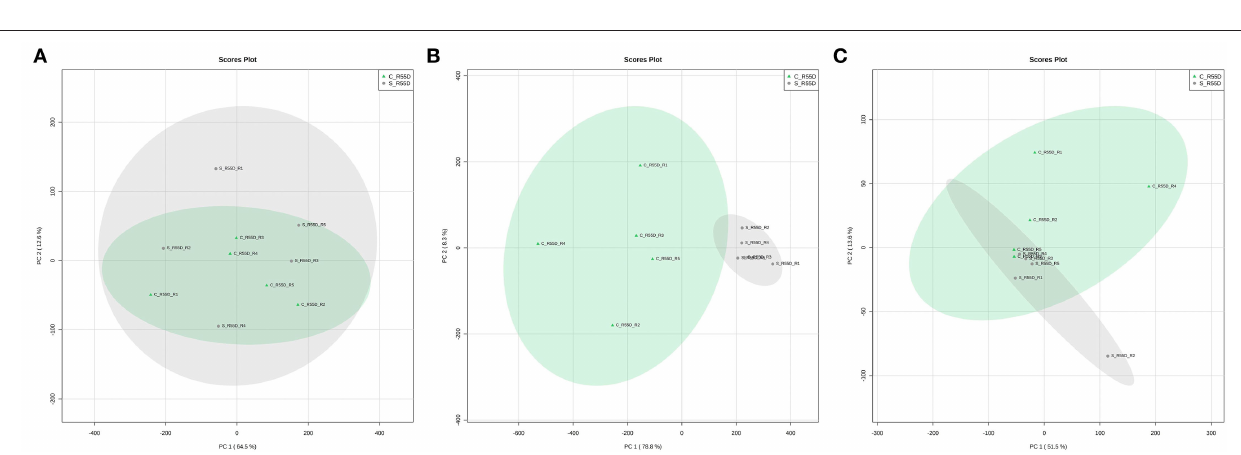
FIGURE 4 | PCA score plots comparing roots samples from control and stressed plants at 55 DAT—LTS1 (Long-term stress 1). Polar positive (A) , polar negative (B) , and lipidic positive (C)